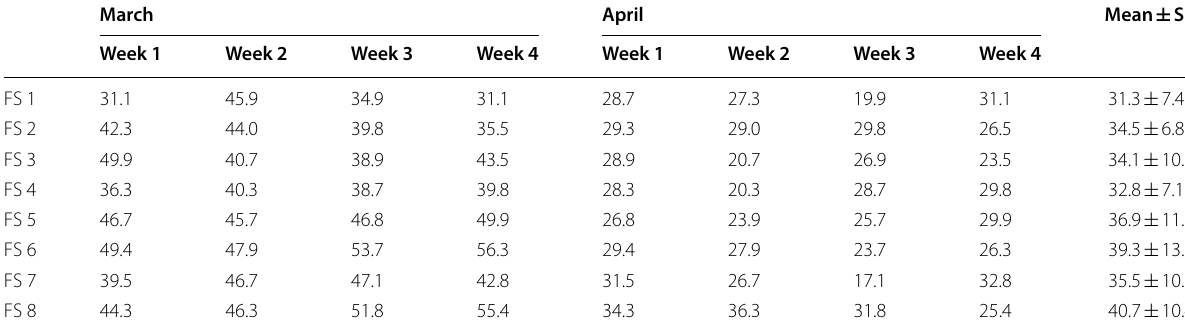
(µg/m 3 ) in March and April 10